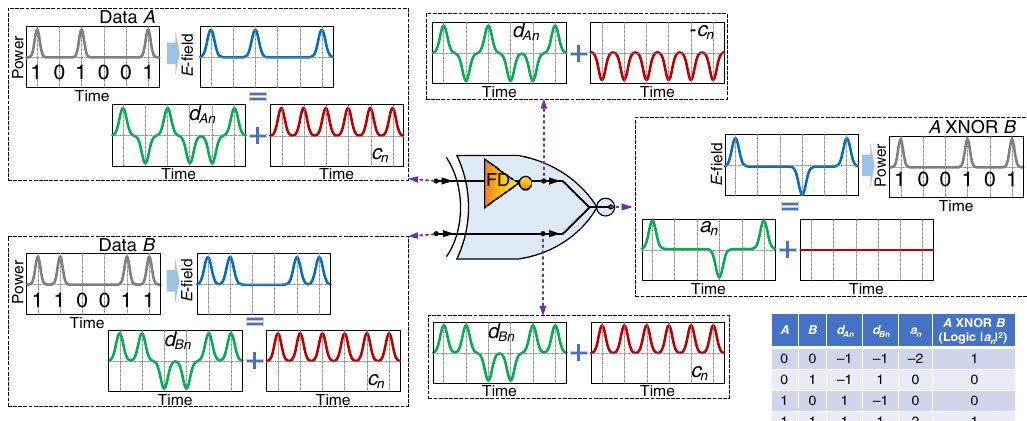
Fig. 2 The operation principle of the proposed frequency-domain zero switching-energy logic XNOR gate. Conceptual illustration of how a frequency- domain (FD) passive NOT gate and a combiner can be used to implement an ultrafast passive XNOR operation. The FD NOT gate inverts the clock of Data A (red), which when summed with Data B at the combiner destructively cancels the clock of Data B . The resulting output fi eld, a n , is simply the sum of the data fi eld amplitude of Data A , d An , with the data fi eld amplitude of Data B , d Bn , a n = d An + d Bn . The output intensity, | a n | 2 , gives the XNOR operation. The corresponding truth table is shown in the lower right-hand